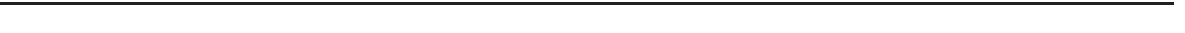
Table 3. Search terms used.